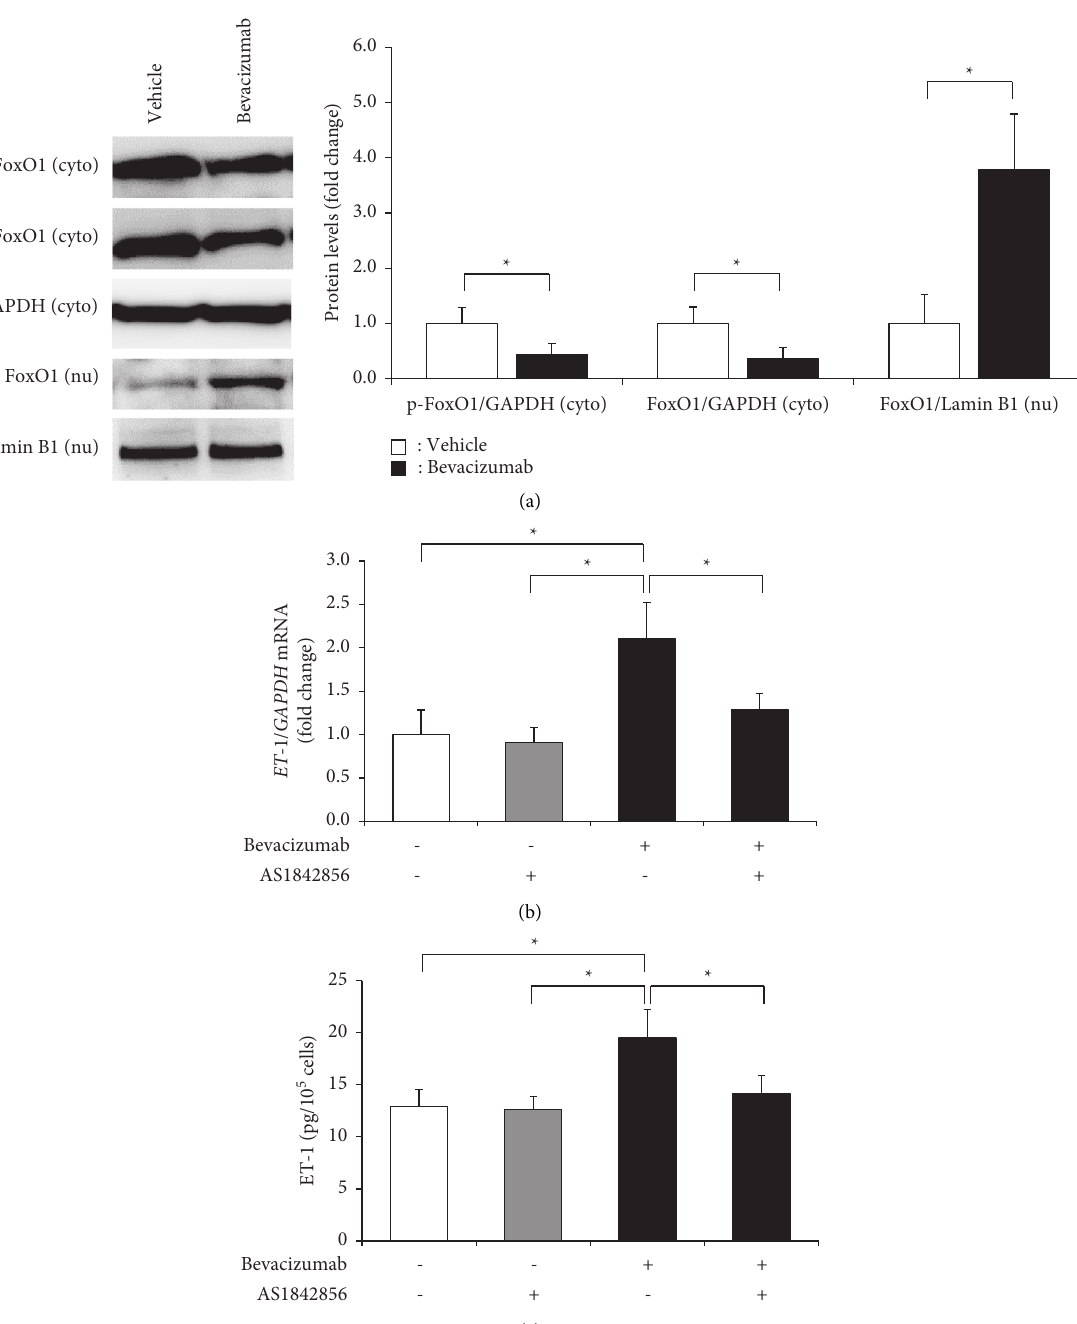
Figure 3: The nuclear localization of FoxO1 was increased in human glomerular microvascular endothelial cells (hGECs) treated with bevacizumab. hGECs were plated in 24-well plates (1 × 10 5 cells/well) for ELISA or 60mm culture dishes (1 × 10 6 cells/dish) for RT-PCR and western blot. hGECs that were 90% confluent were serum-starved for 24h before the experiments were performed. hGECs were treated with 1 µ M bevacizumab and 0.1 µ M AS1842856 (FoxO1 inhibitor) for 8h, and western blots were used to evaluate the changes in FoxO1 protein level in cytosolic (cyto) and nuclear (nu) fractions after bevacizumab treatment (a). The levels of ET-1 mRNA (b) and ET-1 protein (c) were measured using real-time RT-PCR and the ELISA after bevacizumab and AS1842856 treatment. Data shown are means ± SD ( n � 3; ∗ p < 0.05). The experiments were repeated at least three times, with reproducible